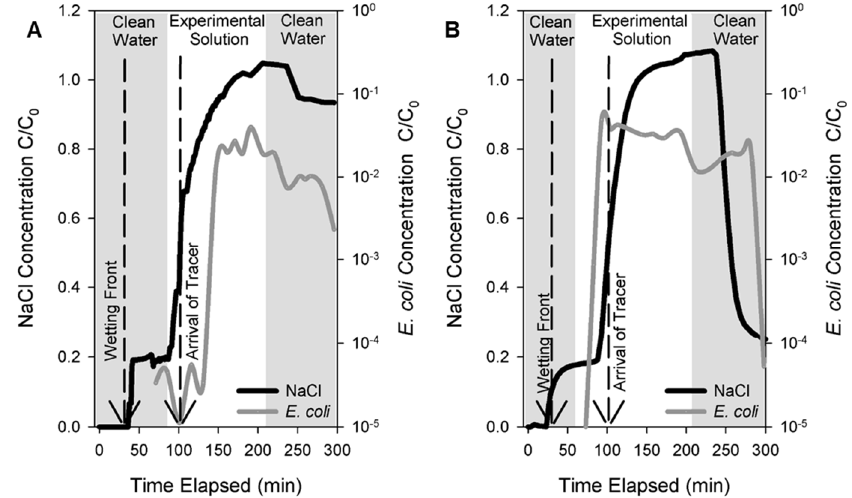
Figure 2. Breakthrough curves obtained during the field tracer experiment for the ( A ) conventional shale Tree Filter and the ( B ) Innovative Red Cedar Tree Filter.